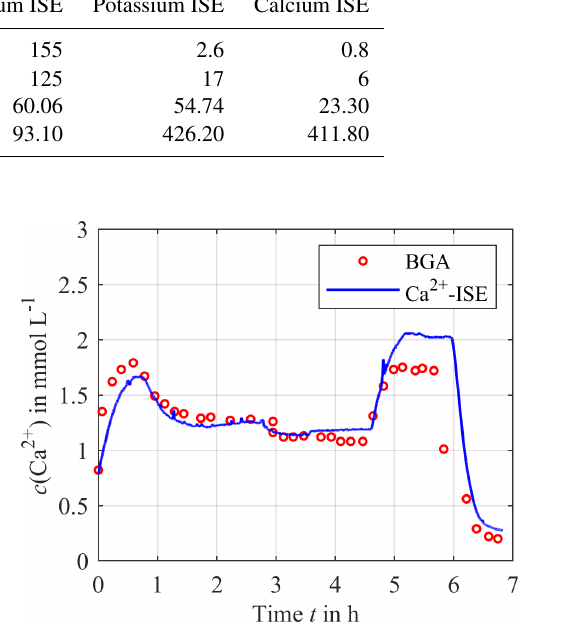
Figure 7. Continuously measured calcium concentration using the calibrated ISEs (solid blue line) compared to the blood gas analyzer as a reference (red